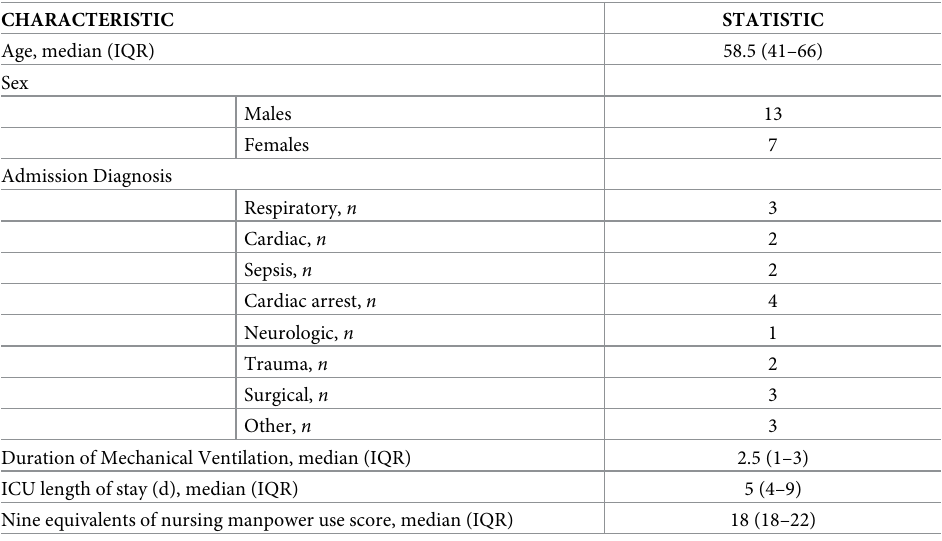
Table 1. Patient demographic and clinical